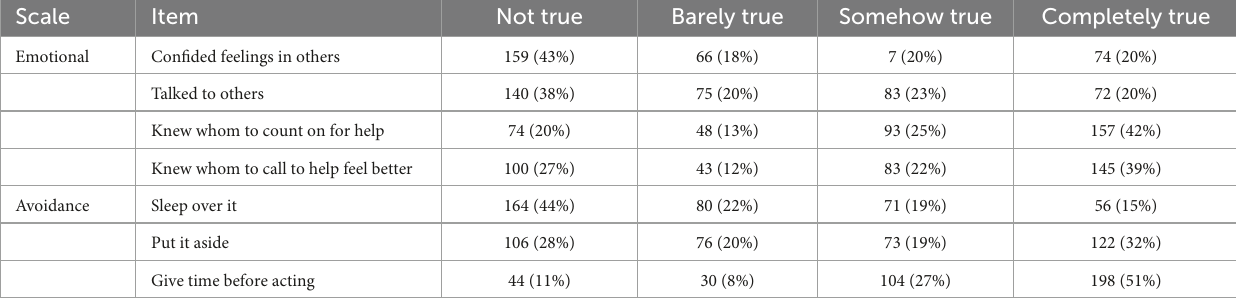
TABLE 1 Avoidance and emotional support coping